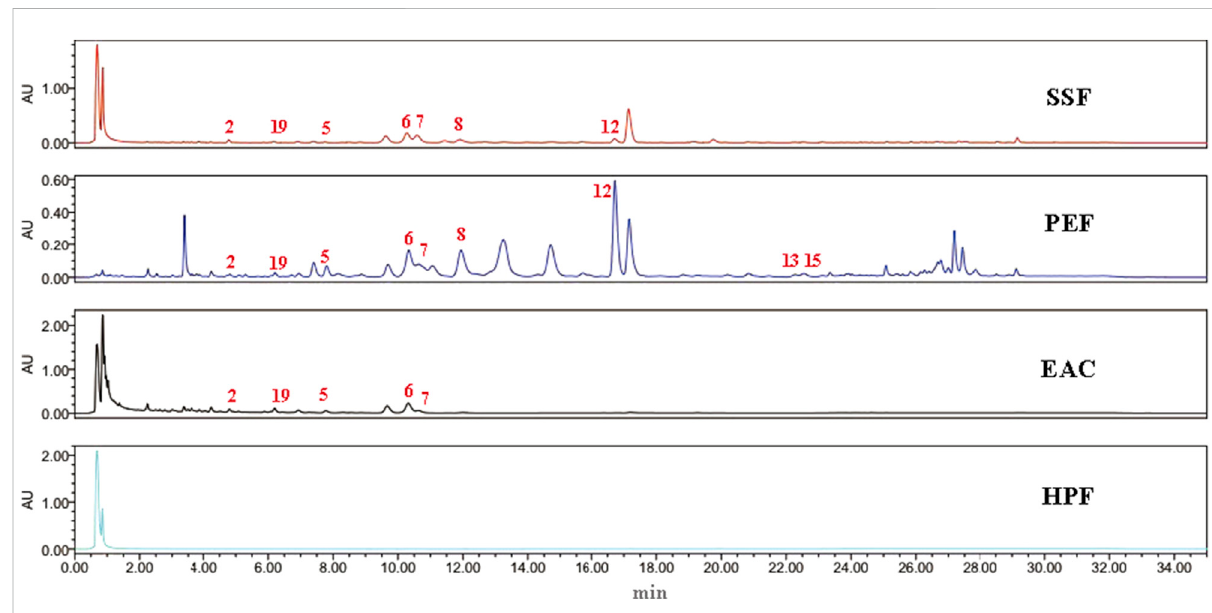
FIGURE 1 UPLC chromatography of SSF, PEF, EAC, and HPF. 2, gomisin J; 19, pregomisin; 5, gomisin G; 6, schisantherin A; 7, schisantherin B; 8, schisanhenol; 12, deoxyschizandrin; 13, benzoylgomisin O; and 15, angeloylgomisin